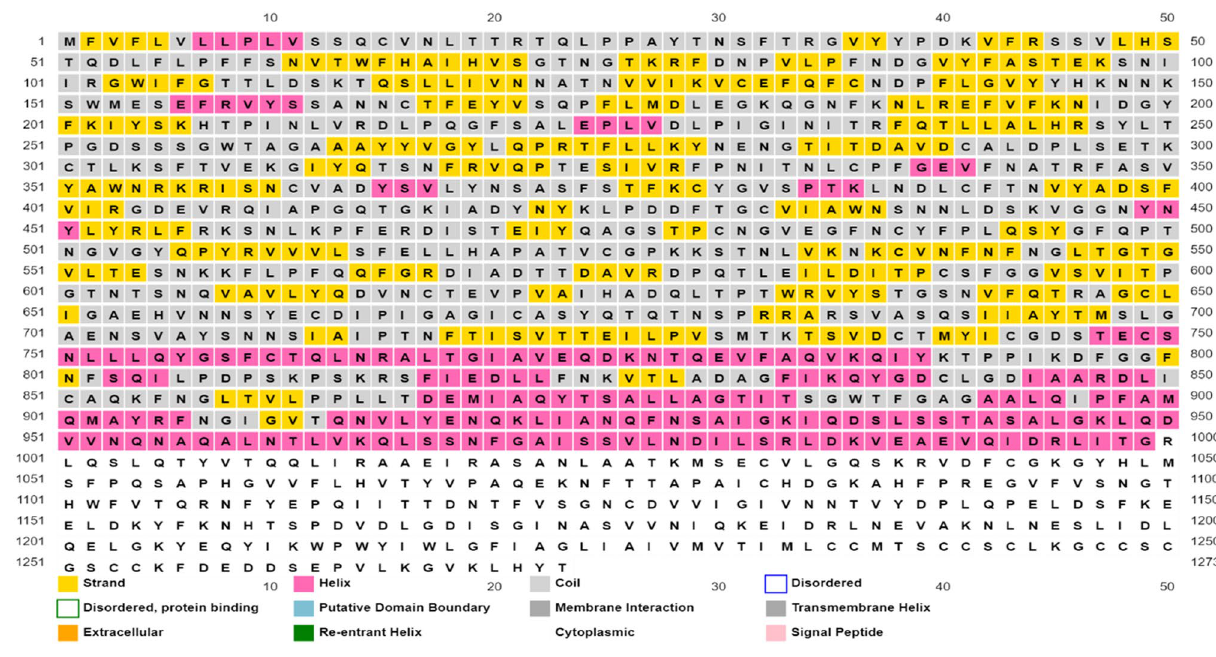
Figure 1. Prediction of secondary structure via PSIPRED 31